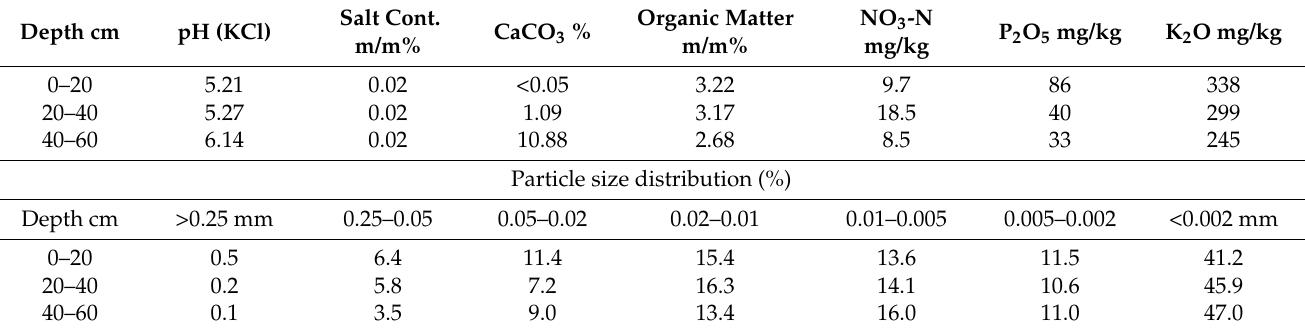
Table 1. Main soil properties of the studied soil in Karcag, Hungary.